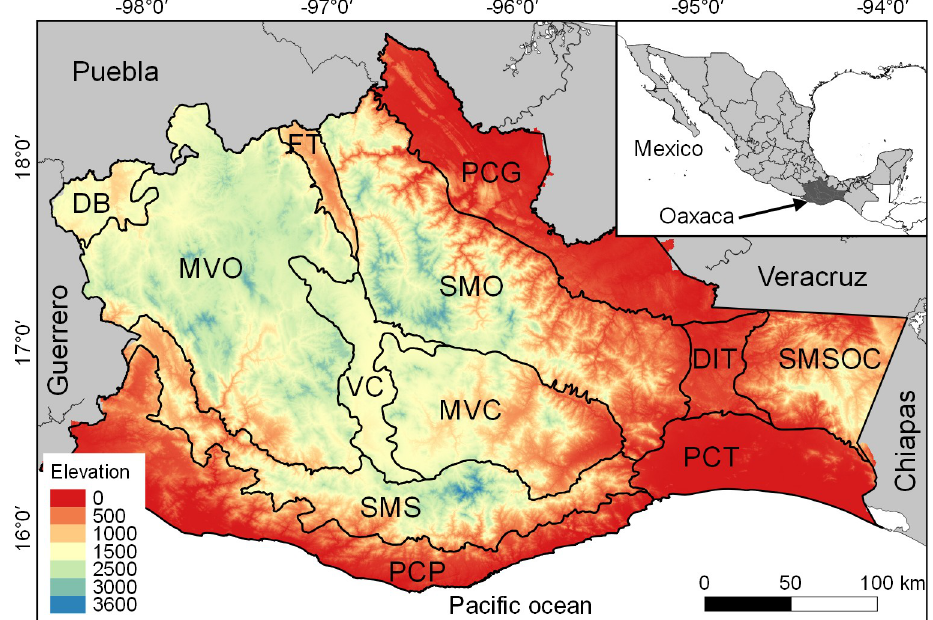
Fig 1. Location of Oaxaca, including the physiographic subprovinces of the state: Depresio´n del Balsas (DB), Monta ñ as y Valles del Occidente (MVO), Fosa de Tehuaca´n (FT), Sierra Madre de Oaxaca (SMO), Valles Centrales de Oaxaca (VCO), Monta ñ as y Valles del Centro (MVC), Sierra Madre del Sur (SMS), Planicie Costera del Pacı´fico (PCP), Planicie Costera de Tehuantepec (PCT), Depresio´n del Istmo de Tehuantepec (DIT), Sierra Madre del Sur de Oaxaca y Chiapas (SMSOC), and Planicie Costera del Golfo (PCG).